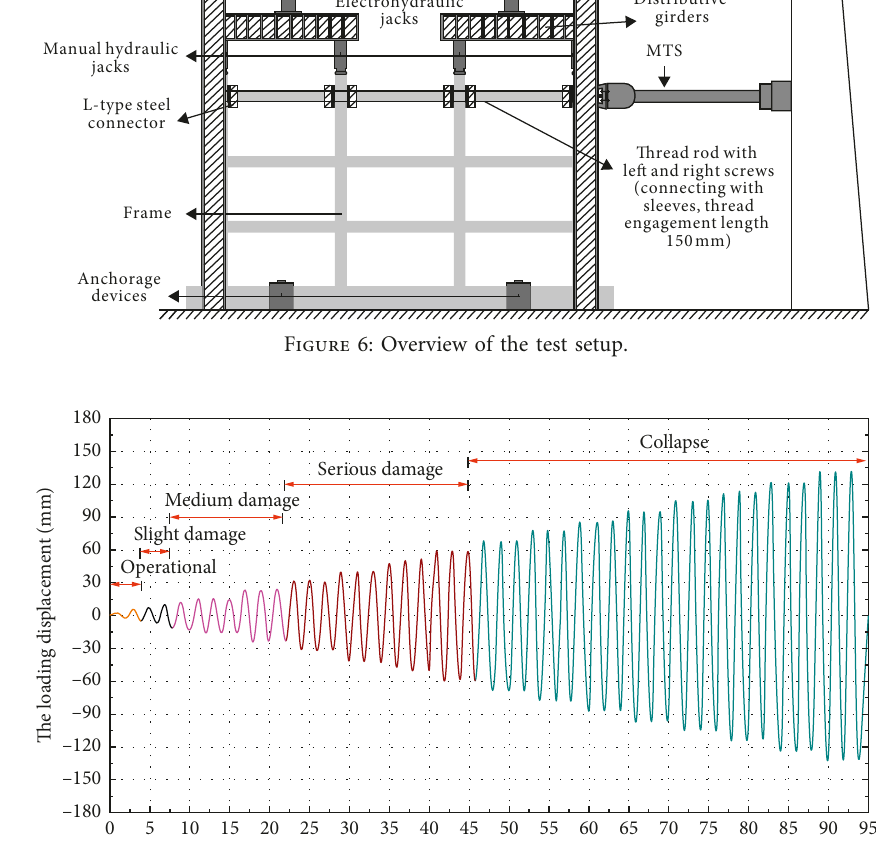
Figure 7: Cyclic loading history.